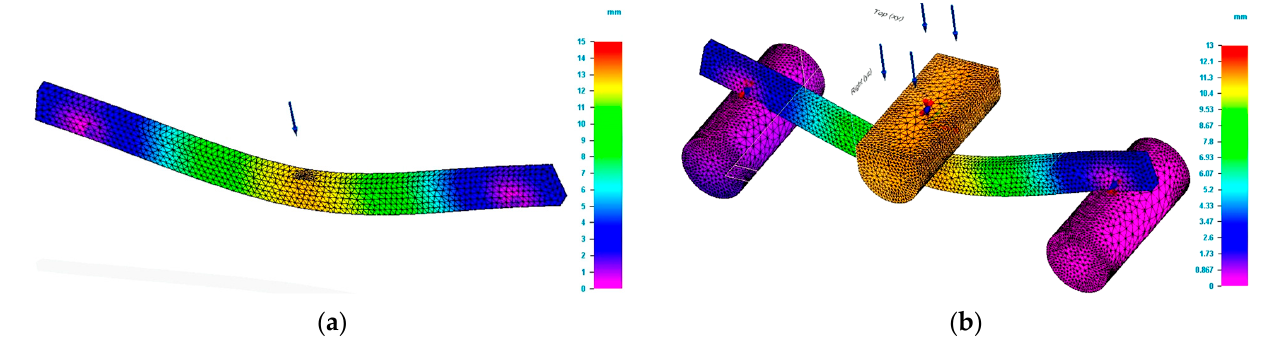
Figure 9. Result of simulation process for P_R15 specimen (total deformation values). ( a ) Total deformation values for simple modelling. ( b ) Total deformation values for complex modelling.